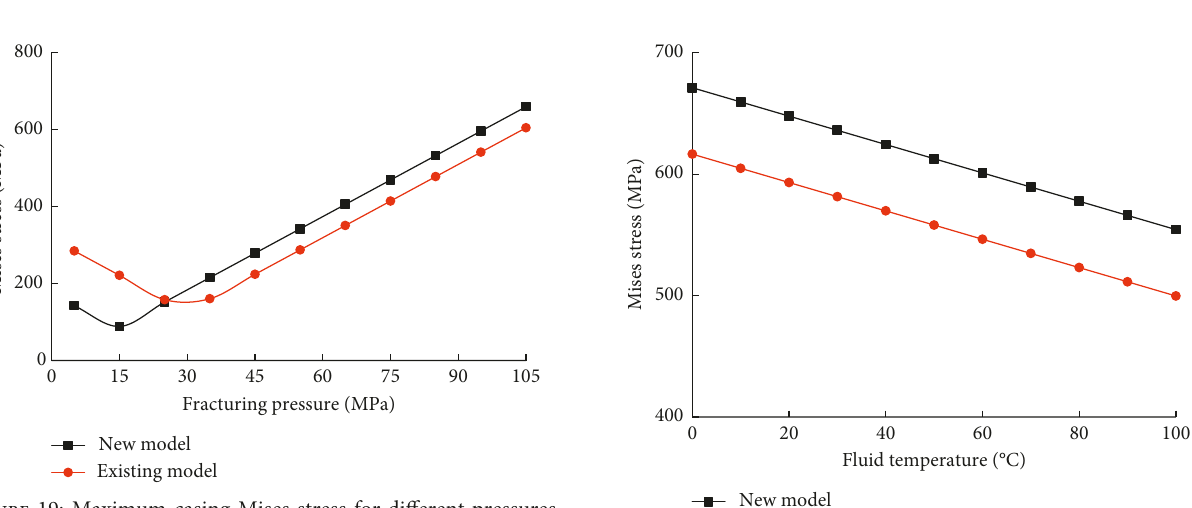
Figure 18: Casing Mises stress for different stress nonuniformity indexes: (a) casing internal stress and (b) maximum casing stress.